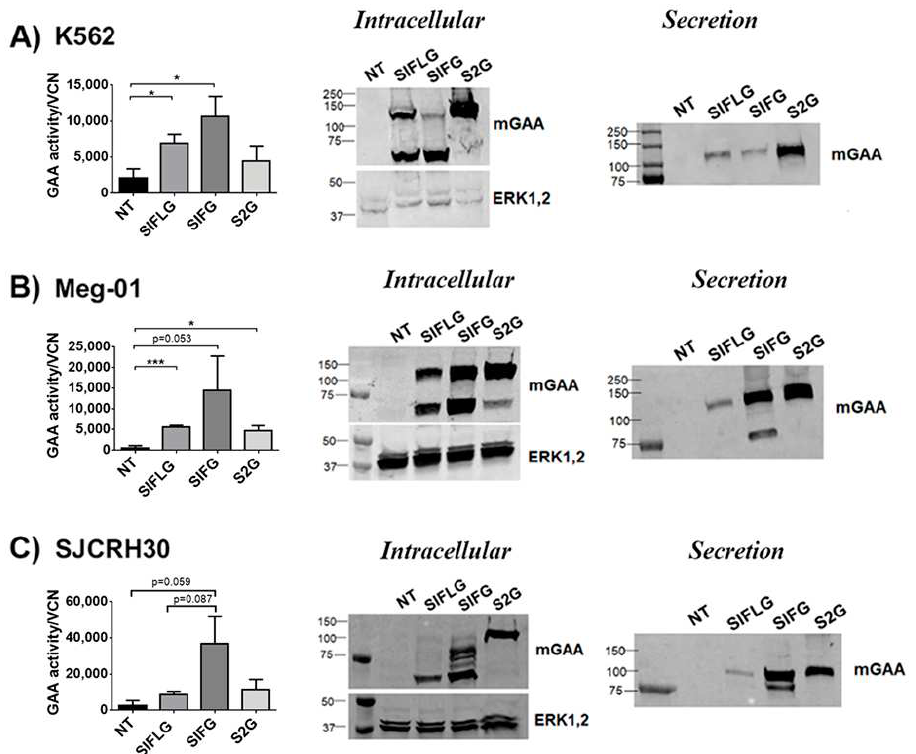
Figure 5. The optimised mGAA are expressed and secreted in different human cell lines. ( A – C ) Left graph, analysis of mGAA intracellular activity in cell lysates (NT = WT non-transduced) or after correcting by vector copy number (VCN) (SIFLG, SIFG and S2G) of transduced K562 ( A ), Meg-01 ( B ) and SJCRH30 ( C ) cells. Middle panel and right panels: Western blots of intracellular (middle) or secreted (right) mGAA from K562 ( A ) Meg-01 ( B ) and SJCRH30 ( C ) non-transduced (NT) or transduced with SIFLG, SIFG and S2G LVs, as indicated. Statistical analyses: unpaired t-test (two tails, * p < 0.05, ** p < 0.01, *** p < 0.001). Values represent means +/- SEM of at least three separate experiments.